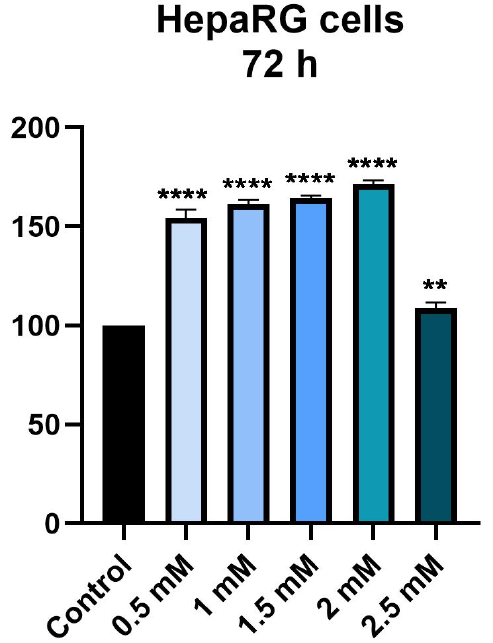
Figure 2. In vitro assessment of the effect of Met (0.5, 1, 1.5, 2 and 2.5 mM) exerts on the viability of HepaRG after 72 h of treatment. The data are expressed as viability percentages (%) normalized to control cells and expressed as mean values ± SD of three independent experiments performed in triplicate. To identify the statistical differences between the Control and the Met-treated group, a one-way ANOVA analysis was conducted followed by the Dunnett’s multiple comparisons post-test (** p < 0.01; **** p <